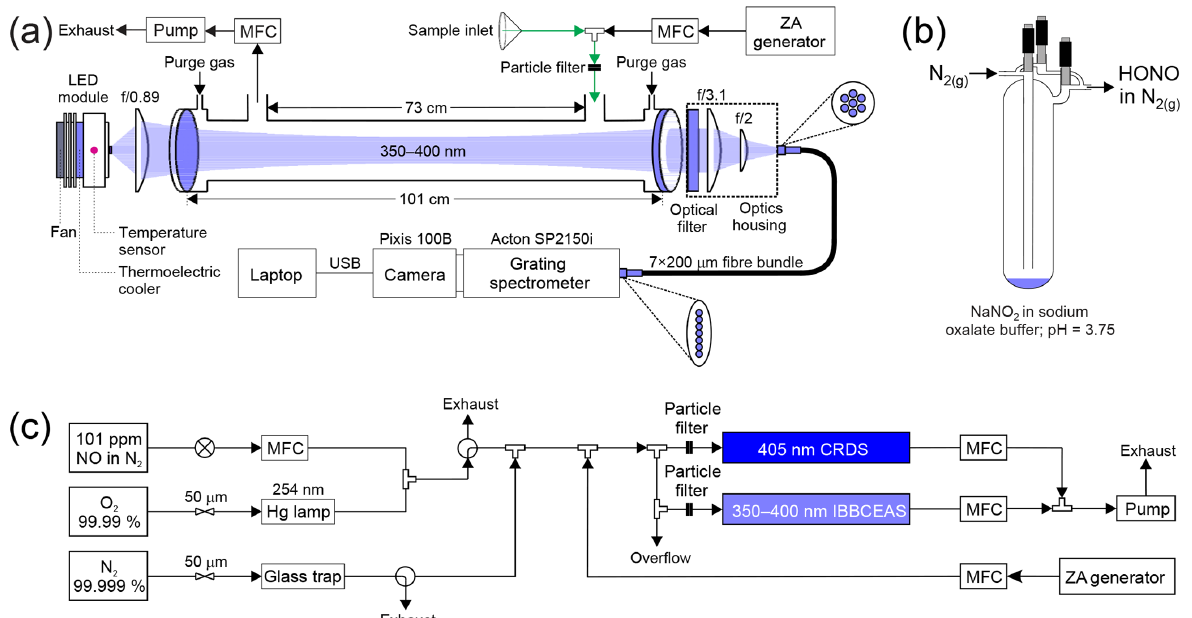
(Fig. S2 and Table S1 in the